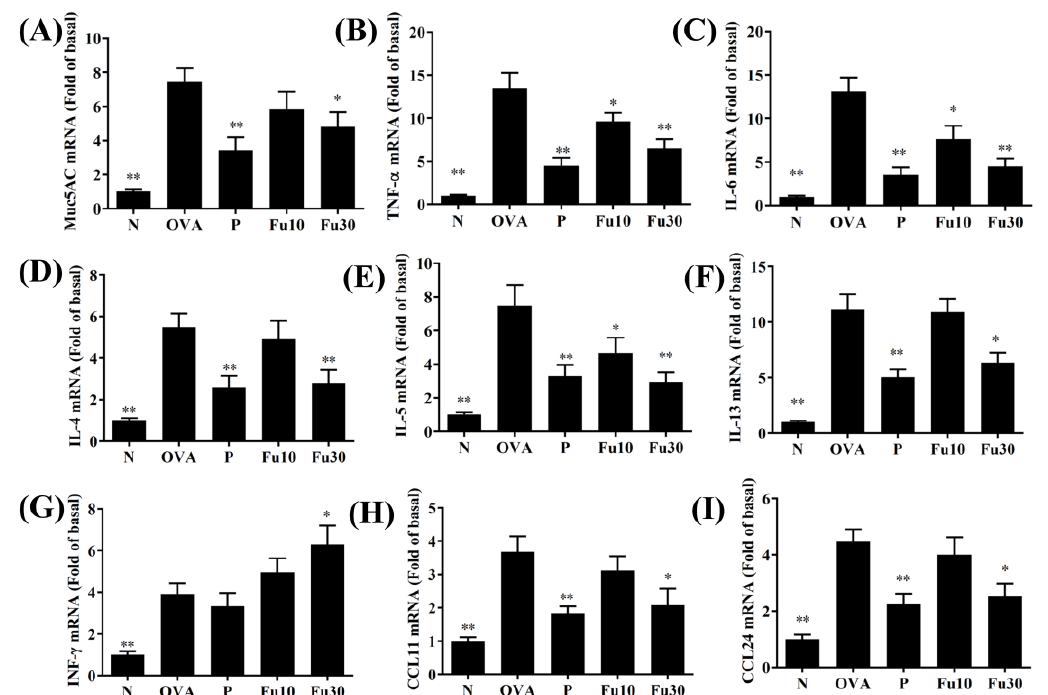
Figure 6. The effects of fucoxanthin (Fu) on cytokine, chemokine, and inflammatory mediator mRNA expression in the lungs. Gene expression levels were determined by the real-time RT-PCR of RNA extracted from the lung tissues of normal (N) and OVA-stimulated (OVA) mice with or without Fu (10 or 30 μM) treatment. ( A ) Muc5AC, ( B ) TNF- α, ( C ) IL-6, ( D ) IL-4, ( E ) IL-5, ( F ) IL-13, ( G ) IFN- γ, ( H ) CCL11, and ( I ) CCL24. Fold changes in expression were measured relative to β -actin (internal control). Three independent experiments were analyzed. Data are presented as mean ± SEM. * p < 0.05, ** p < 0.01 compared to the OVA control group. 10 mg/kg and 30 mg/kg fucoxanthin were named as Fu10 and Fu30, respectively. 5 mg/kg prednisolone was named as P.